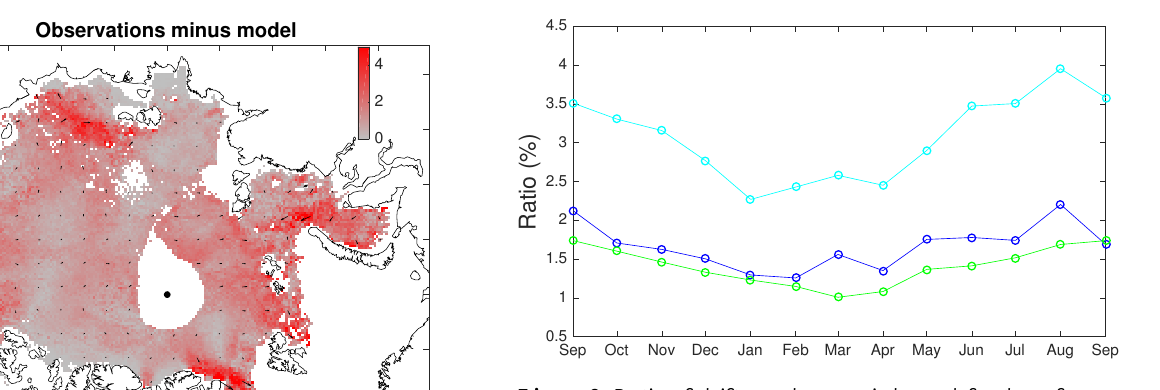
Figure 8. Ratio of drift speed over wind speed for the reference simulation forced with ASR-Interim (cyan) and a simulation forced with ERA-Interim (blue). As a reference the same ratio is shown for the IABP buoys drift speed climatology over the ERA-Interim wind speed climatology